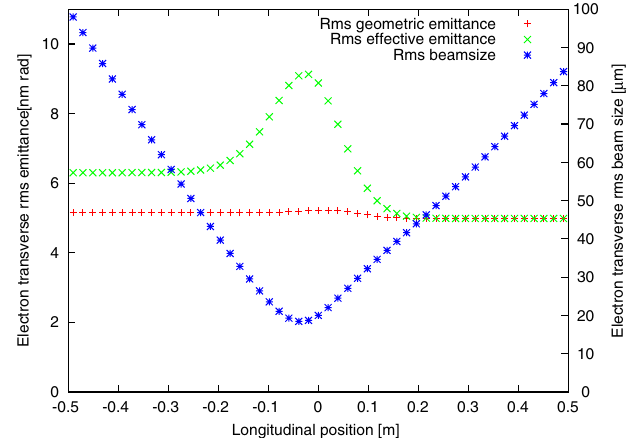
FIG. 5. (Color) Evolution of beam size and rms emittance (geo- metric and effective) of the electron beam for (cid:6) (cid:5) ¼ 0 : 2 m at s (cid:5) ¼ 0 m .